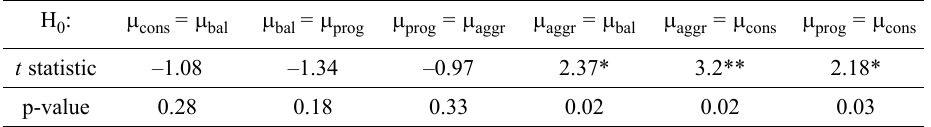
Table 14. Results of hypothesis testing across 4 fund categories